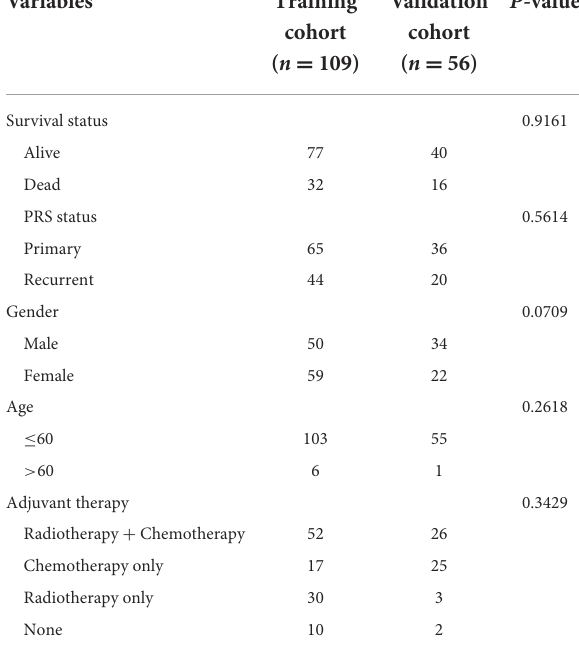
TABLE 1 Corresponding clinical data of the patients in two cohorts.